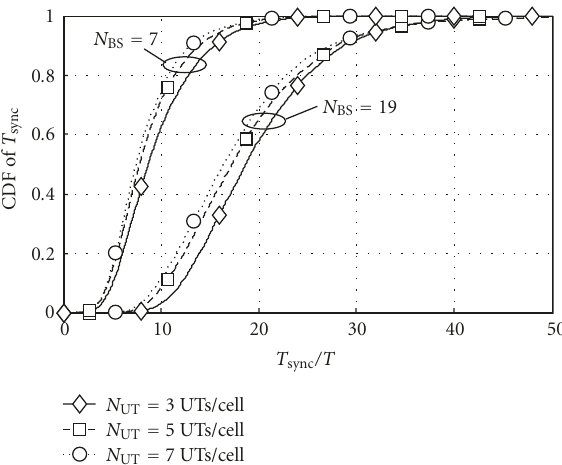
Figure 11: CDF of the normalized time to synchrony for an hexagonal cell deployment scenario with N BS = 7 and N BS = 19 base